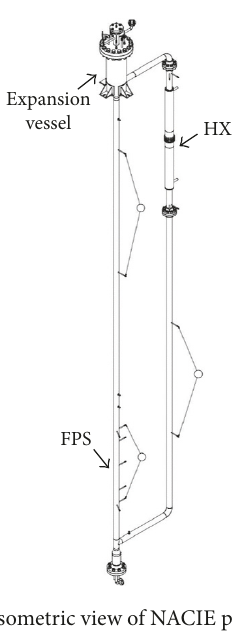
Figure 4: Isometric view of NACIE primary loop.